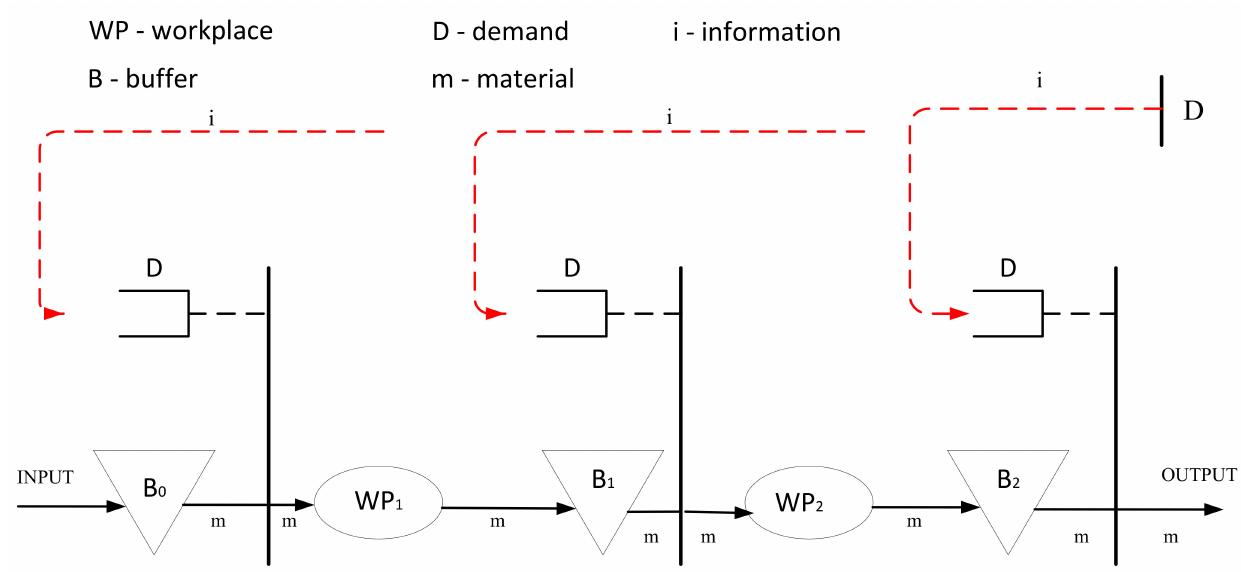
Figure 1. Production push system.